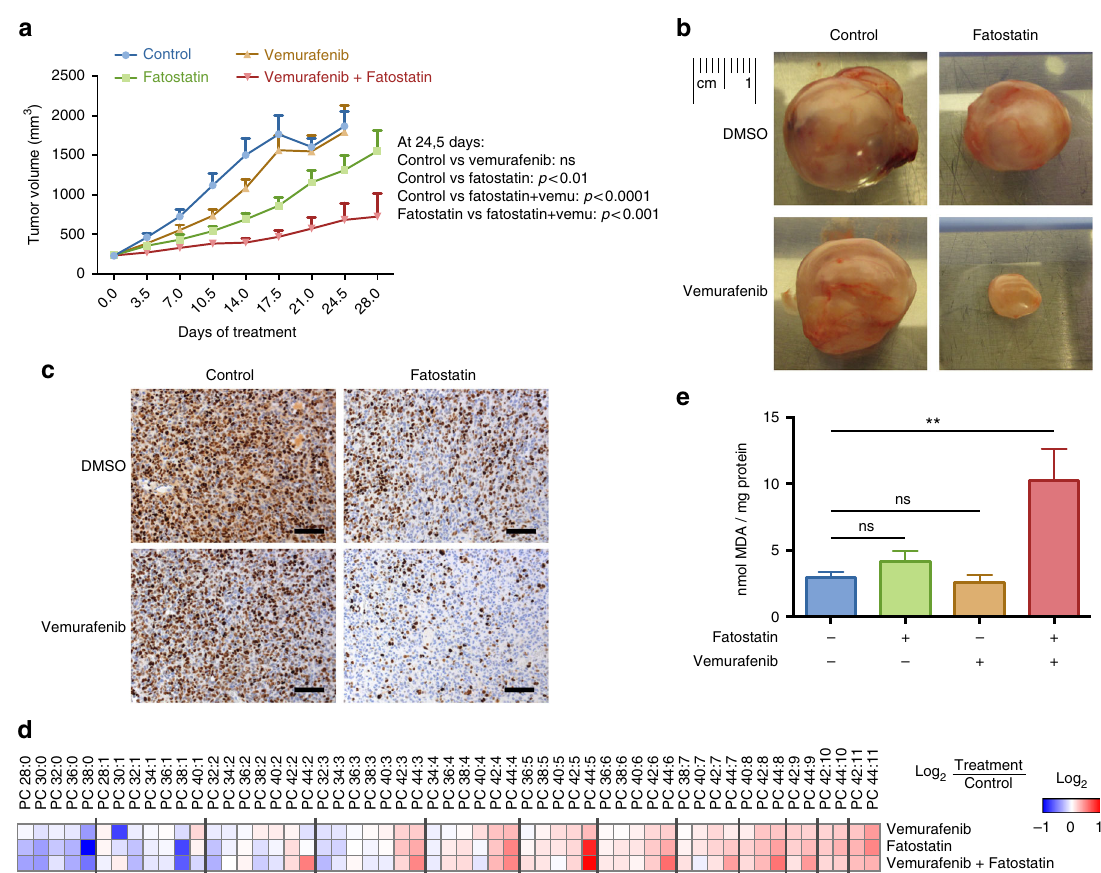
Fig. 5 SREBP-1 protects vemurafenib-resistant cells from lipid peroxidation. BRAF V600E -mutant PDX tumors (mel6 model) were transplanted into nude mice (NMRI-Fox1nu) which were blindly administered vehicle ( n = 8), fatostatin (20 mg/kg) ( n = 10), vemurafenib (20 mg/kg) ( n = 10) or a combination of vemurafenib and fatostatin ( n = 10) (daily by oral gavage). a Tumor size was measured blindly with digital calipers every 3 days. The tumor pictures in (b) show the tumors that represent the median of their respective cohort. c Expression of Ki67 protein in PDX tumors that represent the median of their respective cohort. Scale bars indicate 100 μ m. d Lipidomics of PDX tumor homogenate. e MDA quanti fi cation of PDX tumor homogenate. The data represent the average over all mice for each cohort compared to the control. Data are represented as mean ± s.e.m. (** p <